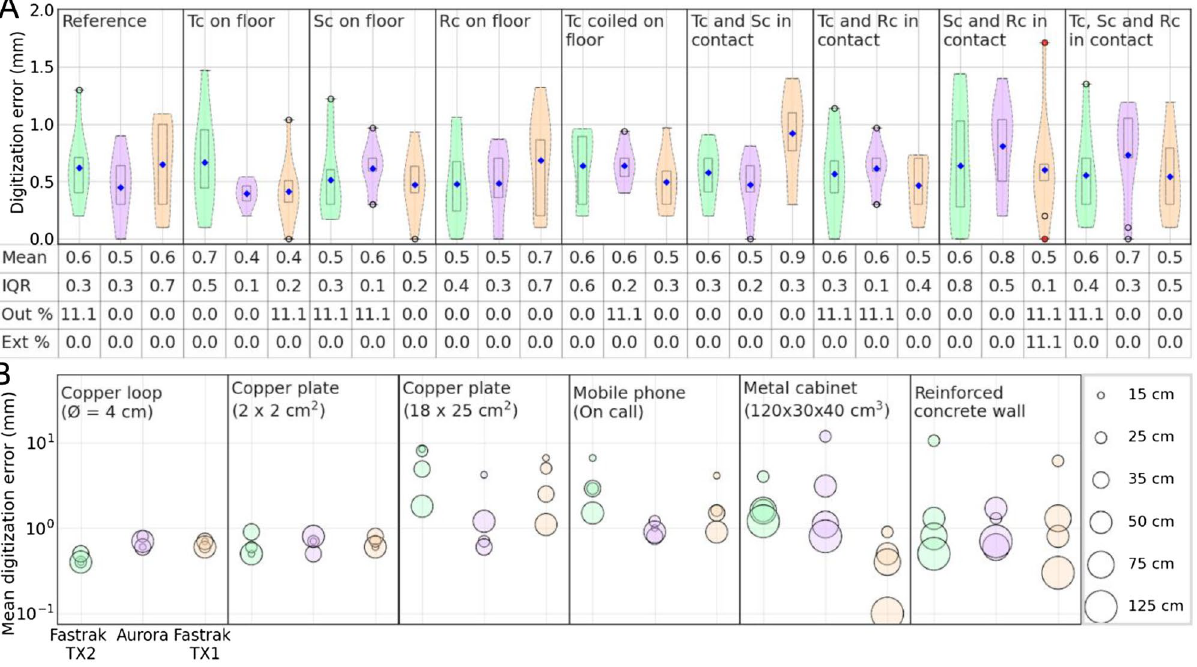
Figure 7. Digitization error when using the 3D test frame with ( A ) transmitter (Tc), stylus (Sc), or reference receiver (Rc) cables in various positions; and with ( B ) interfering objects at varying distances from the transmitter; the marker size encodes the transmitter-to-object